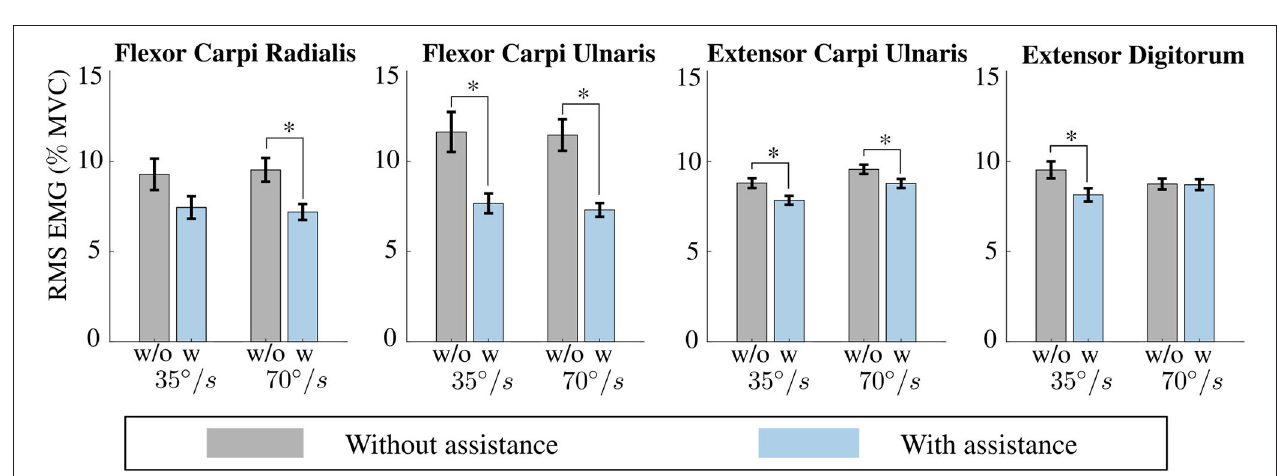
FIGURE 10 | Reduction in muscular activity. The assistance provided by the exosuit reduced the muscular activity while performing a load lifting task at two different flexion speeds, 35 and 70 ◦ /s. Reductions were statistically significant for all the muscles except for the flexor carpi radialis (FCR) at 35 ◦ /s and for the extensor digitorum (ED) at 70 ◦ /s. *means data are statistically significant with p <